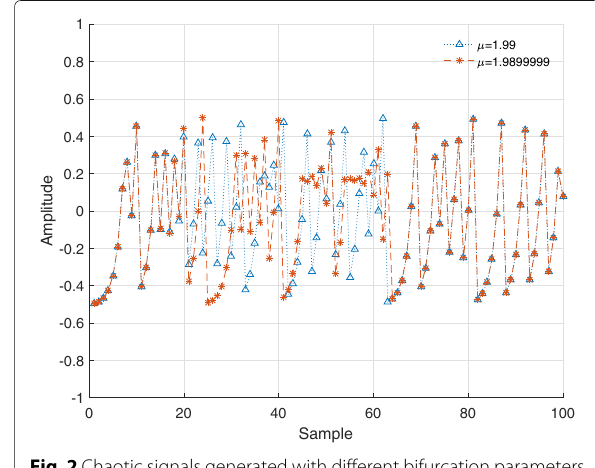
Fig. 2 Chaotic signals generated with different bifurcation